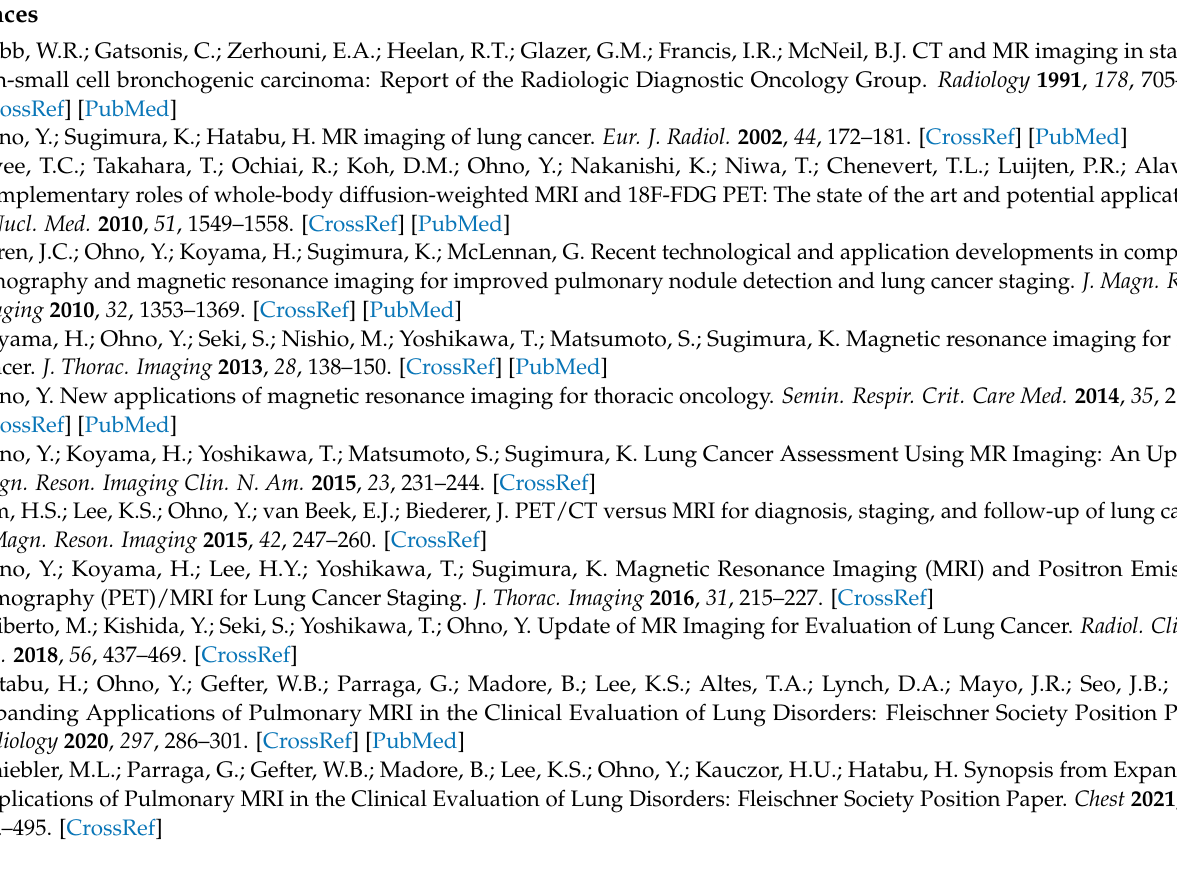
they were scored as 1. Although this was a true-positive case, there were two false-negative sites and one false-positive site. ( b ) STIR image (3200/60/150) in coronal plane shows lung metastases (small arrows) and bone metastases (large arrows) as having high signal intensity, scored as 4 and 5, respectively. This was diagnosed as a true-positive case on whole-body MRI with and without DWI. ( c ) Integrated FDG-PET/CT images demonstrate bilateral lung metastases (arrowheads) and bone metastases (arrows), both of which were scored as 5. This was diagnosed as a true-positive case on integrated FDGPET/CT. Colored bar: standardized uptake value; gray bar: Hounsfield